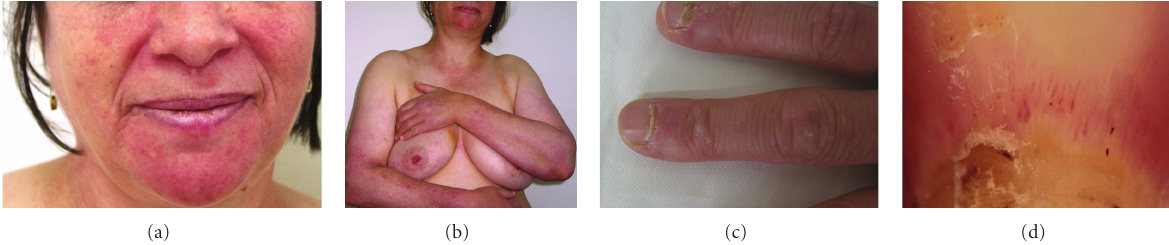
Figure 1: (a) Erythematous-violaceous plaques on face, (b) arms, and sun-exposed regions, and (c) periungual telangiectasias were shown via (d) capillaroscopy.